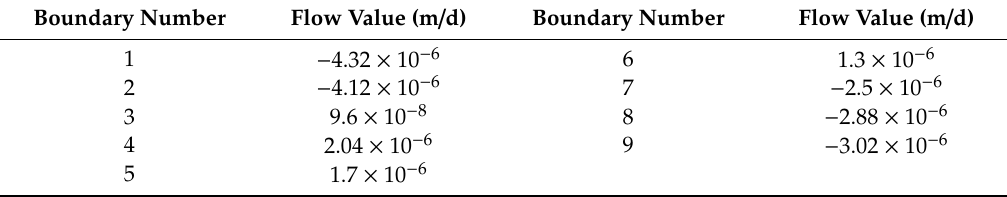
Figure 9. Locations of the fluid flux boundaries. Table 4. Flow value of different boundaries